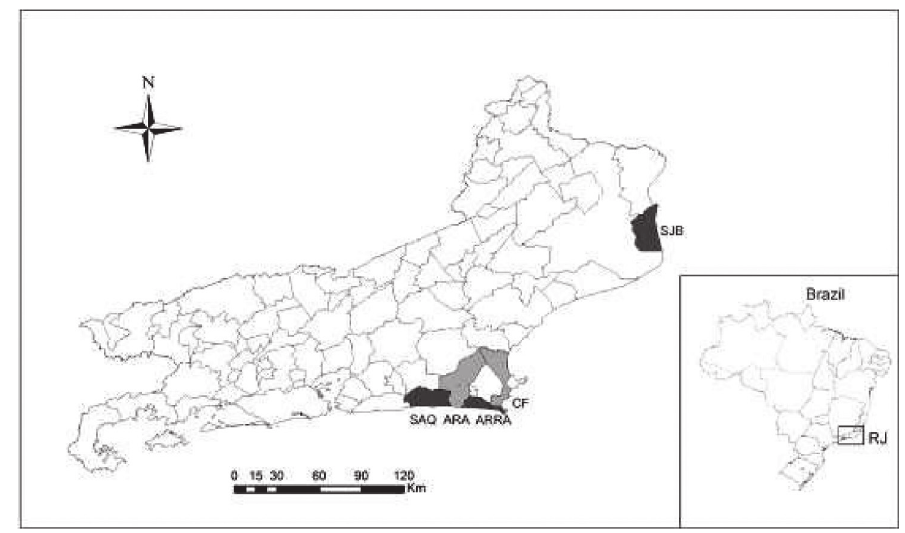
Figure 1 - Location of sites of collection in restinga vegetation from Rio de Janeiro state,